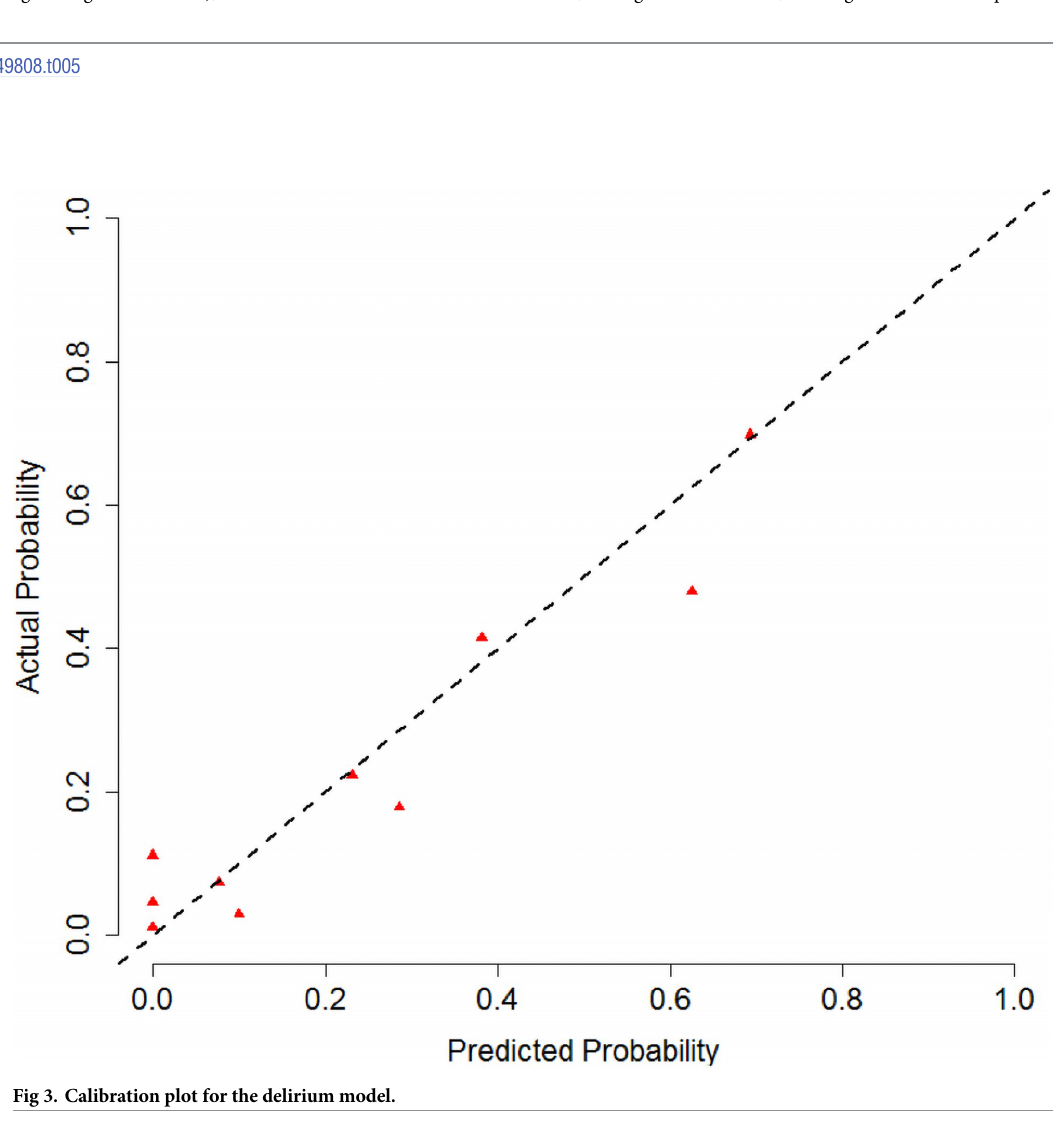
Fig 3. Calibration plot for the delirium